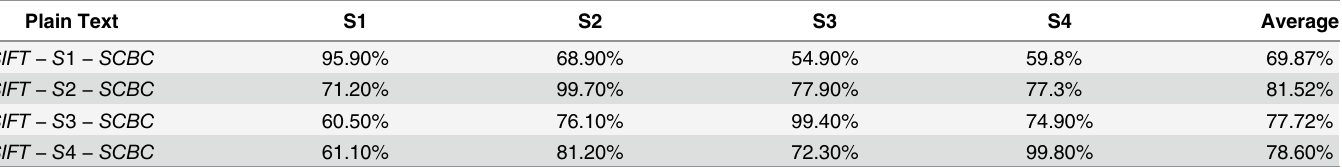
Sizes S1, S2, S3 and S4 with non-rotated ligatures are shown along y-axis, as a test data. The correct classi fi cation rate (%) is shown along x-axis for each distinct SCBC descriptor.